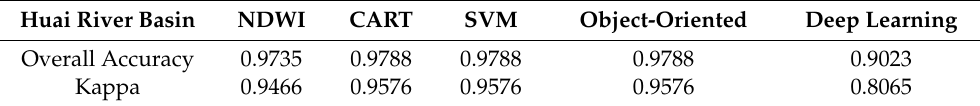
Table 6. Evaluation of the accuracy of Huaihe River Basin water extraction